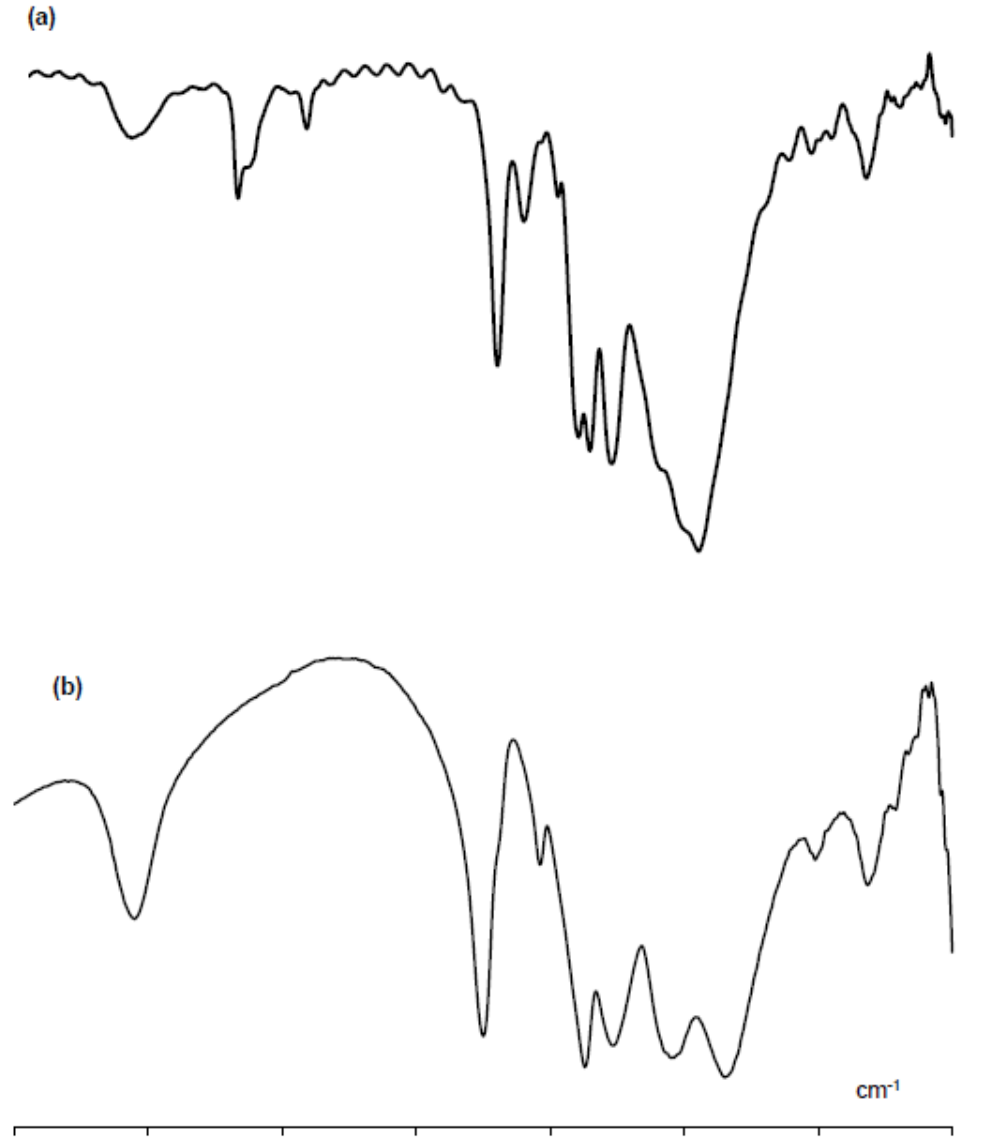
− 1 ), measured as KBr disks, of ( a ) TBA-1 Figure 2. FT-IR spectra in the polyoxoanion region (1800–400 cm −1 ), measured as KBr disks, of ( a ) Figure 2. FT-IR spectra in the polyoxoanion region (1800–400 cm and ( b ) K 6 [B- α -H 3 P 2 W 15 O 59 {Al(OH 2 )} 3 ] · 14H 2 O. ◦ The 31 P NMR spectrum of TBA-1 in DMSO-d 6 containing a drop of water at 23.8 C showed two main signals at − 6.36 and − 11.80 ppm with approximately 1:1 integrated intensities arising from the two internal phosphorus atoms, as shown in Figure 3a. The signals di ff ered from those of K 6 [B- α -H 3 P 2 W 15 O 59 {Al(OH 2 )} 3 ] · 14H 2 O ( δ − 8.43, − 13.39) observed in 11:2 (v / v%) DMSO-d 6 / water (Figure 3b), suggesting the formation of a novel polyoxometalate-based